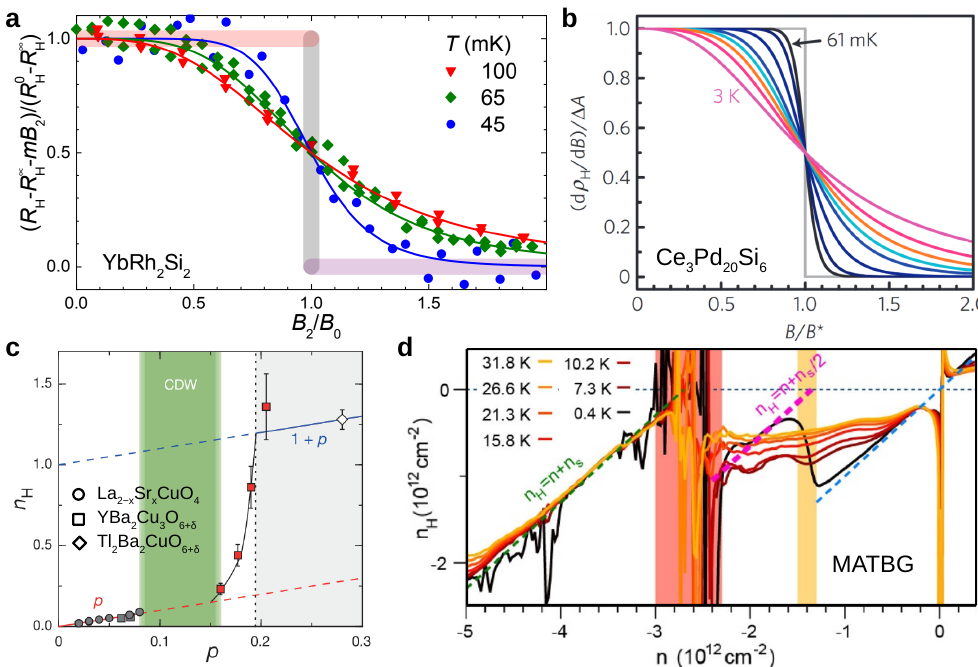
Figure 5. Fermi surface jumps as evidenced by Hall effect measurements in several strange metals. ( a ) YbRh 2 Si 2 , from [32,96]. ( b ) Ce 3 Pd 20 Si 6 , from [75]. ( c ) Substitution series of three high- T c cuprates, from [99]. ( d ) MATBG, from